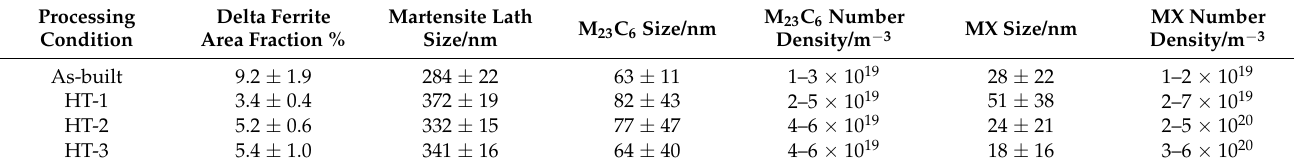
Table 3. Summary of microstructure features in as-built and heat-treated conditions. Processing